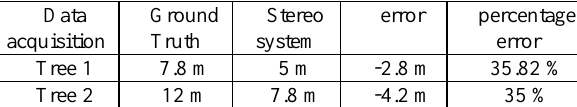
Figure 10. The height measurements and errors